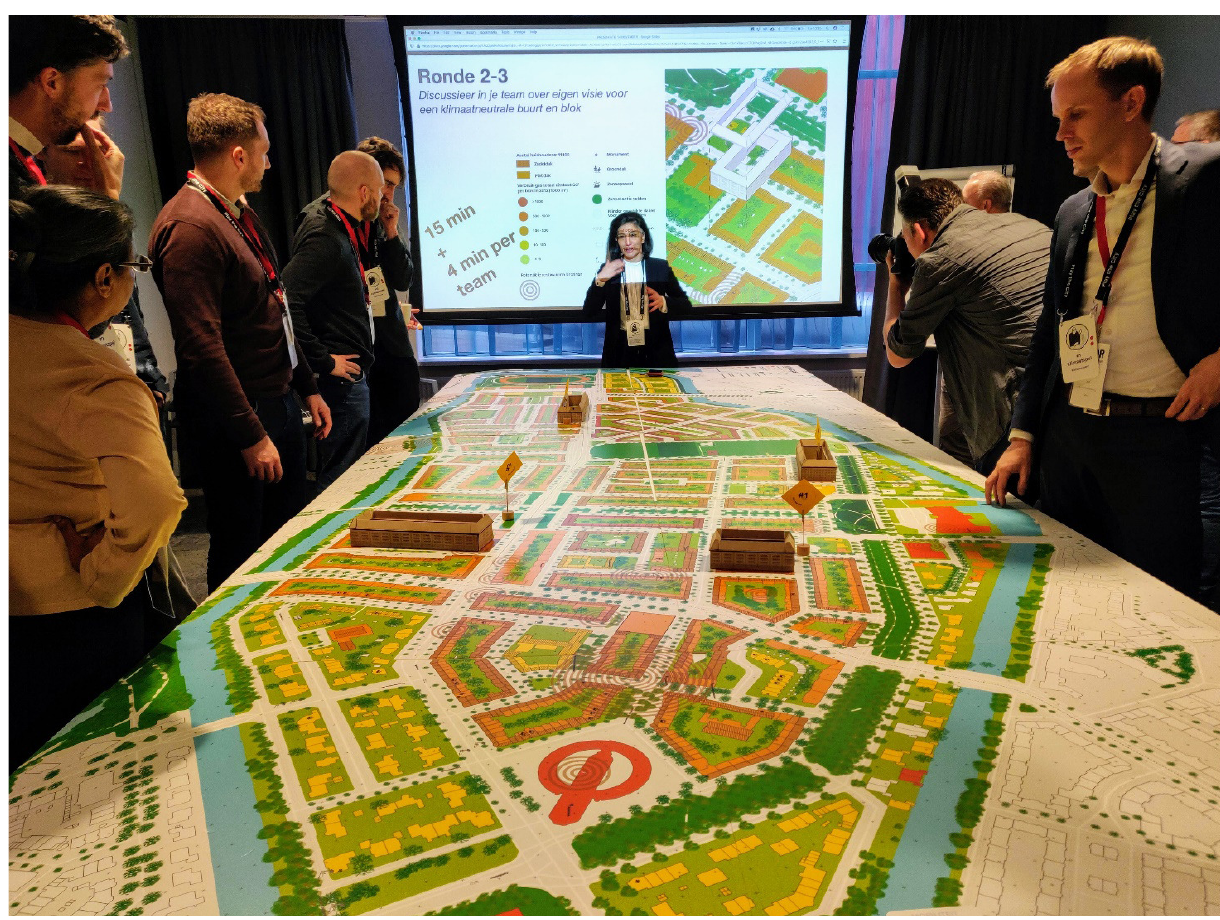
Figure 8. Photo taken during a play session of Klimaatspel in